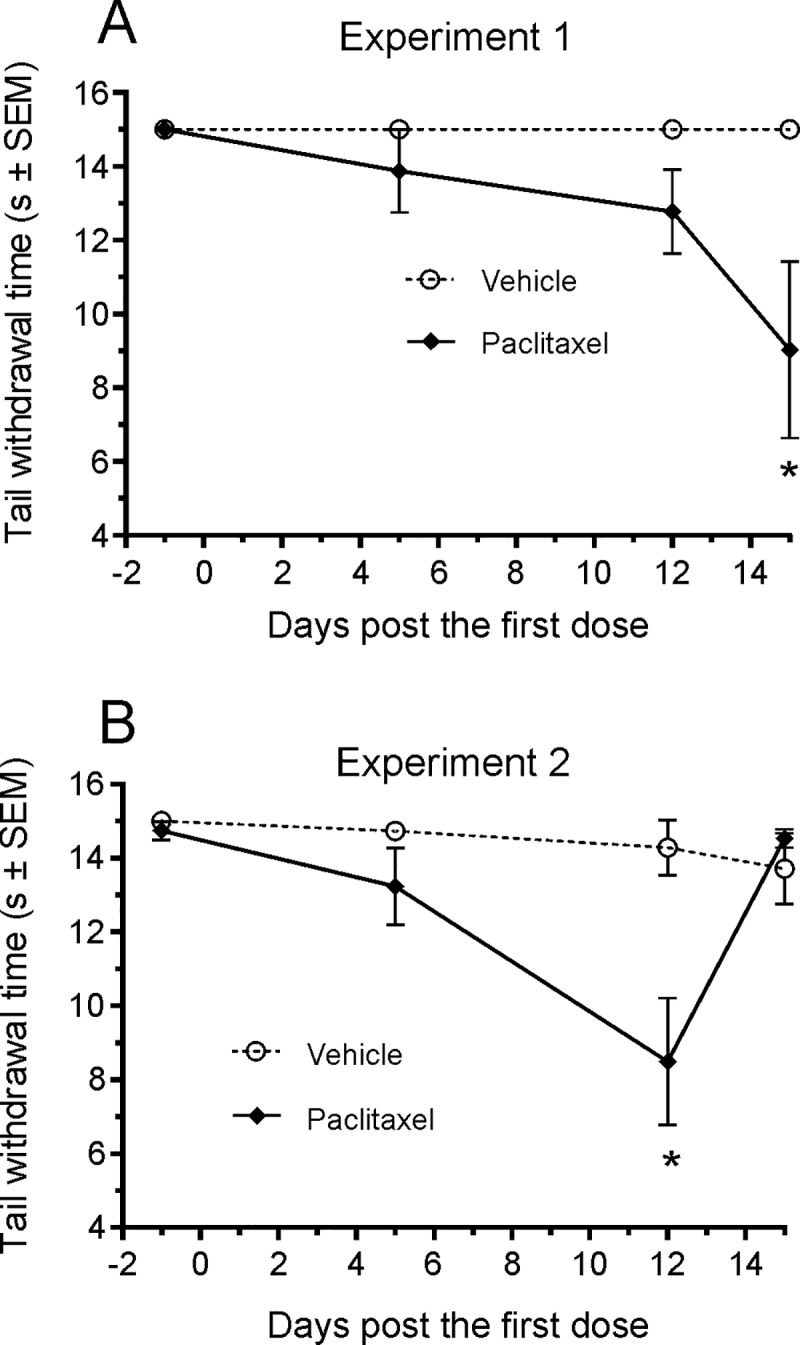
Cold allodynia.(A) The latencies of tail flick (time from cold water (~0°C) stimuli applied to the tip of tail and a flick response) are shown as a function of time following the first dose of paclitaxel or vehicle. All the vehicle control JAX mice had latencies greater than the 15 sec monitoring cut-off time. Five of 8 JAX mice dosed with paclitaxel at 20 mg/kg had reduced latencies on days 12 and 15 and the reduced grouped latency was statistically significant on day 15 (*P < 0.05, Two-way ANOVA). (B). The difference in the latencies between paclitaxel treated (n = 8) vs vehicle treated CRL mice (n = 8) was statistically significant by day 12.